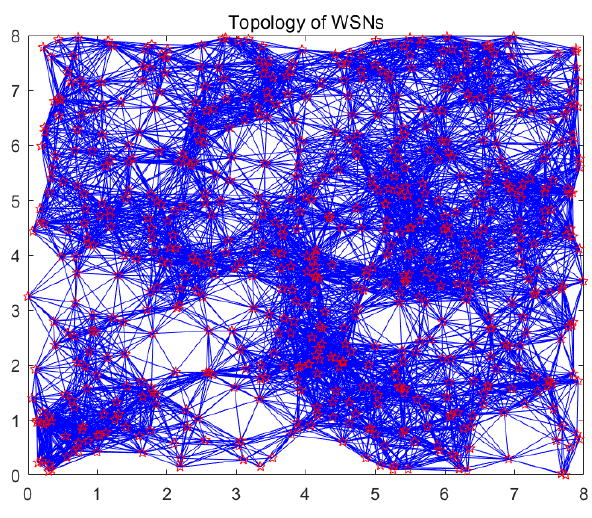
Figure 3. Topology of WSNs.